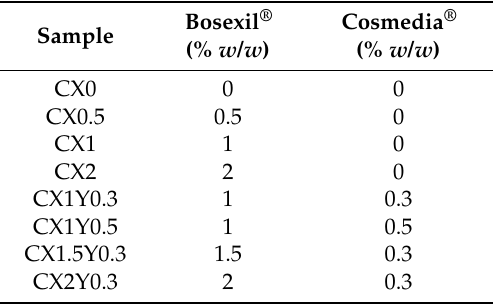
Table 1. Naming and relative concentration of Bosexil ® and Cosmedia ® SP of investigated samples.